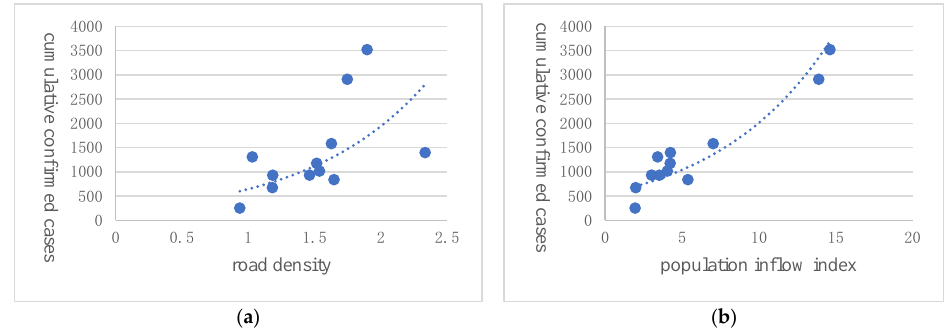
Figure 5. Different cities in Huber Province. Note: Road density ( a ) comes from China’s National Bureau of Statistics. The number of confirmed cases is from China’s National Health Commis-sion, and the population inflow index ( b ) is from Baidu Map. These data are in city level of Hu-bei. The dashed line is the quadratic fitted line. At the inter- provincial level, the scale index of Hubei’s outward migration from 10 January to 23 January 2020 is multiplied by the share of respective migration destinations in quantifying the scale of outward migration of Hubei. The data on the number of con- firmed cases of COVID-19 sourced from the information released by the Health Commis- sions of corresponding provinces, whereas the data on railway and road density are from the China Statistical Yearbook. The scatter graphs are shown as Figures 6 and 7. From the trend lines, we could observe that in the provinces other than Hubei, the cumulative num- ber of confirmed cases of the Coronavirus was positively correlated with both road den- sity, railway density, and the inflow migration index. This was consistent with the situa- tion we observed inside the Hubei Province. That is, the more developed the transporta- tion infrastructure and the higher the migration inflow was, the more extensive the spread of the virus would be.